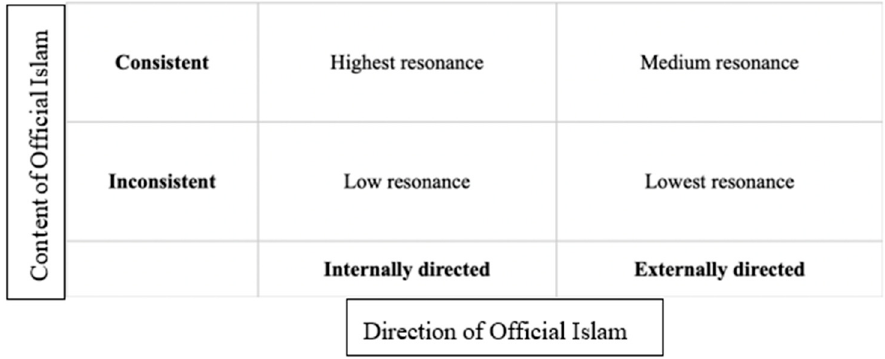
Figure 1. Resonance as the Result of the Content & Direction of Official Islam.